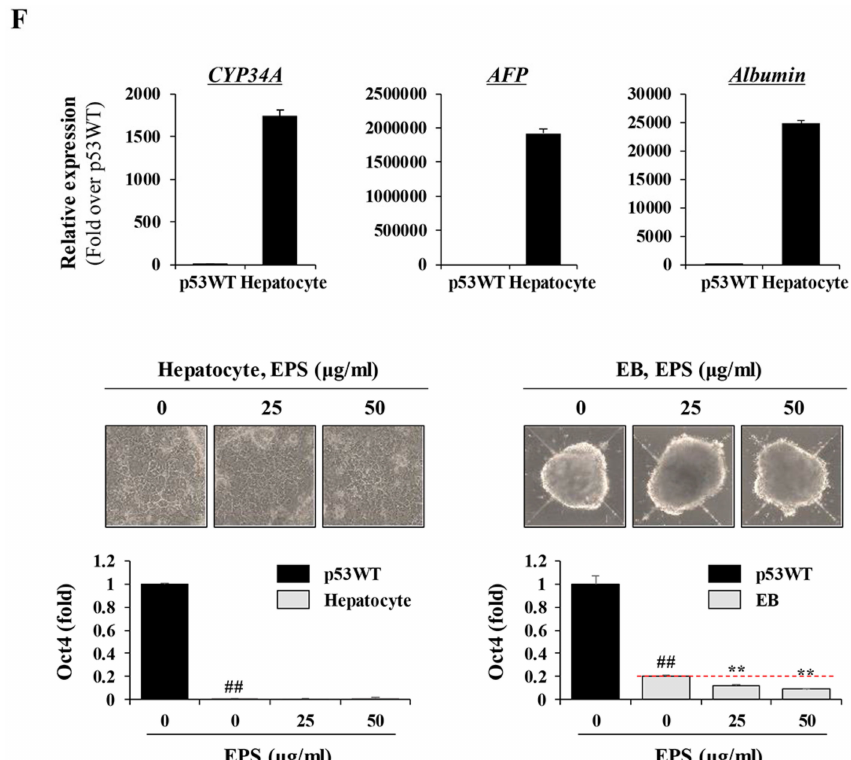
Figure 7. EPS has no cytotoxic e ff ects on hiPSC-derived di ff erentiated cells. ( A ) iPSC-Di ff and p53WT hiPSCs were seeded on 12-well culture plates and treated with 25 and 50 µ g / mL EPS for 24 h. Cell morphology was observed under an inverted microscope and cell viability was assessed by CCK-8 assay. Data are expressed as the mean ± SD from triplicate samples. ( B , C ) After treating iPSC-Di ff with indicated concentrations of EPS for 12 h, the mRNA levels of p21 and Oct4 were measured by real-time PCR analysis. Data are expressed as the mean ± SD from triplicate samples and represented as fold increases relative to that of EPS-untreated cells. ( D ) iPSC-Di ff were treated with 25 and 50 µ g / mL EPS or 0.2 and 0.5 µ M doxorubicin (doxo) for 24 h. The protein levels of p-ATM and p-H2AX were detected by Western blotting. The relative band intensities compared with EPS- or doxo-untreated control cells were calculated using Image J software after normalization to actin expression. Data are representative of two independent experiments. ( E ) iPSC-Di ff and p53WT hiPSCs were treated with 50 µ g / mL EPS or 0.5 µ M doxo for 24 h or 3 h, respectively, and then immunostained with anti-p-H2AX antibody followed by Alexa 594-conjugated anti-rabbit antibody. Nuclei were stained with DAPI and γ -H2AX foci was observed under a fluorescence microscope. ( F ) Hepatic markers in p53WT and hiPSC-derived hepatocytes were analyzed by qPCR. Fold increase over p53WT was expressed as the mean ± SD from triplicate samples. Hepatocytes and embryonic bodies (EBs) were treated with 25 and 50 µ g / mL EPS for 24 h. Morphological changes were observed under inverted microscope and the Oct4 mRNA level was determined by real-time PCR analysis. Data are expressed as the mean ± SD from triplicate samples and represented as fold increases relative to that of EPS-untreated iPSC-Di ff . ** p < 0.01 vs. EPS-untreated control, ## p < 0.01 vs.